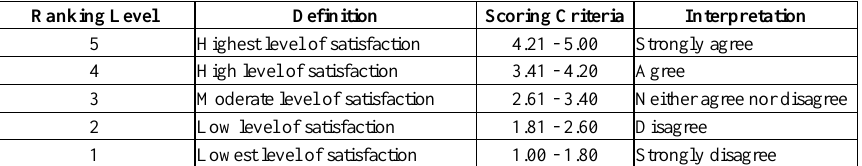
Table 5. Scoring criteria for satisfaction assessment and interpretation